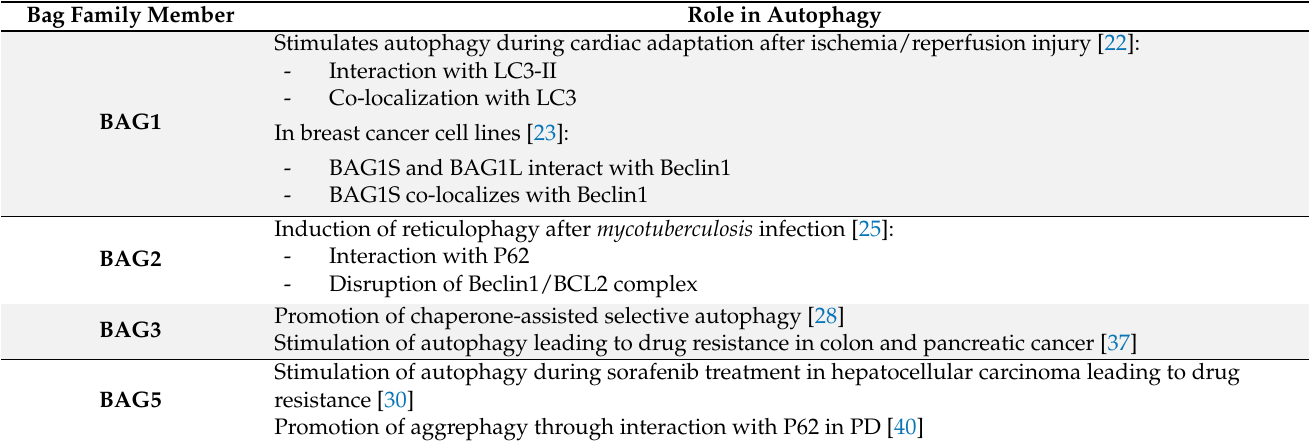
Table 1. Role of BAG family members in autophagy